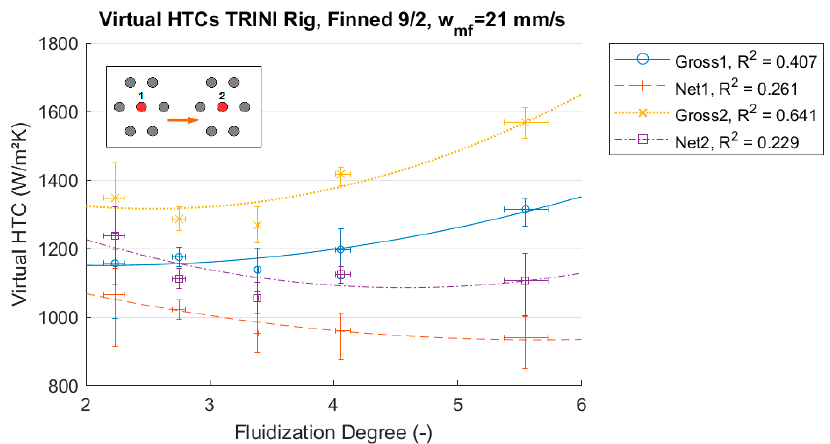
Figure 15. Results of helically finned tubes, pitch 9 mm, fin thickness 2 mm, TRINI test rig, 146 µ m particles. Indices 1 and 2 refer to the different heated